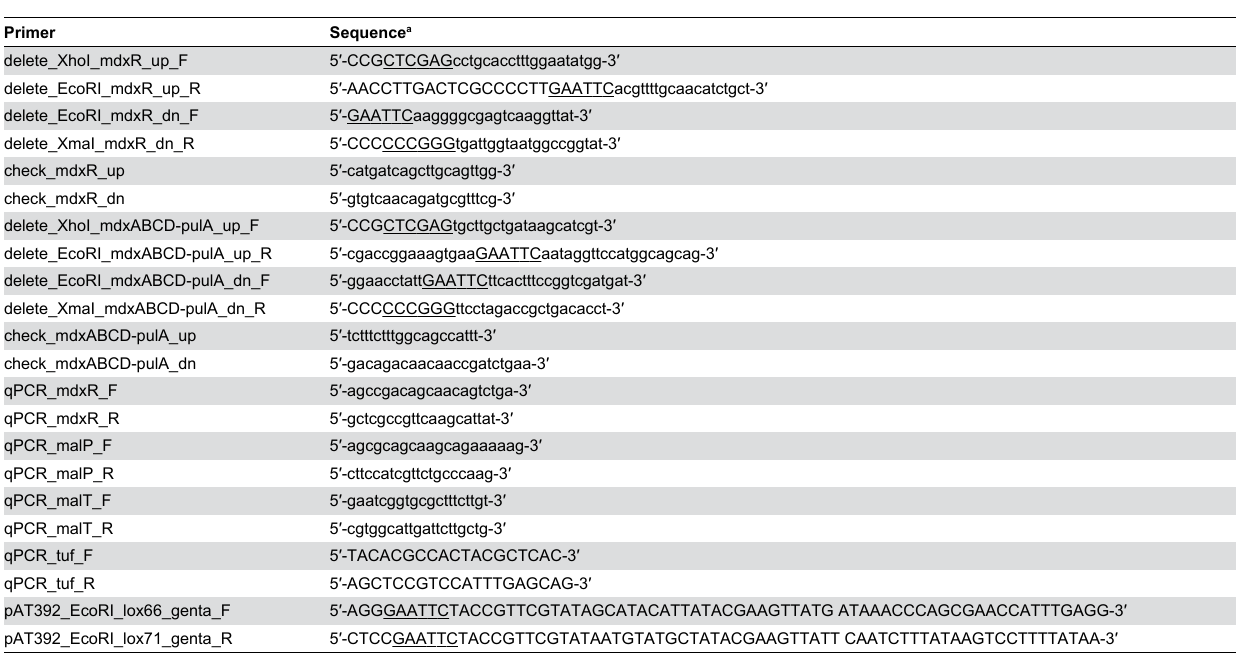
Table 2. Primers used in this study.